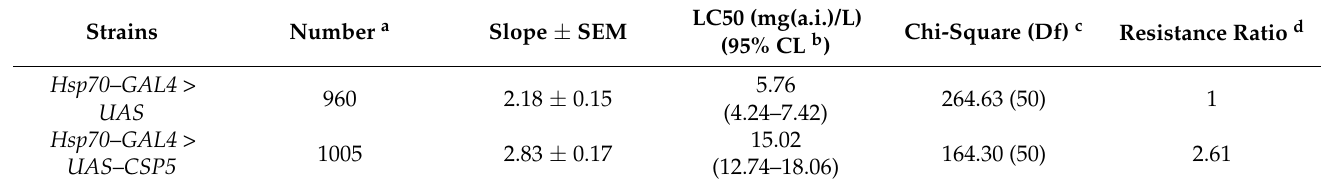
Table 2. Toxicity of omethoate to transgenic strain overexpressing AgosCSP5 and control strain of Drosophila melanogaster .